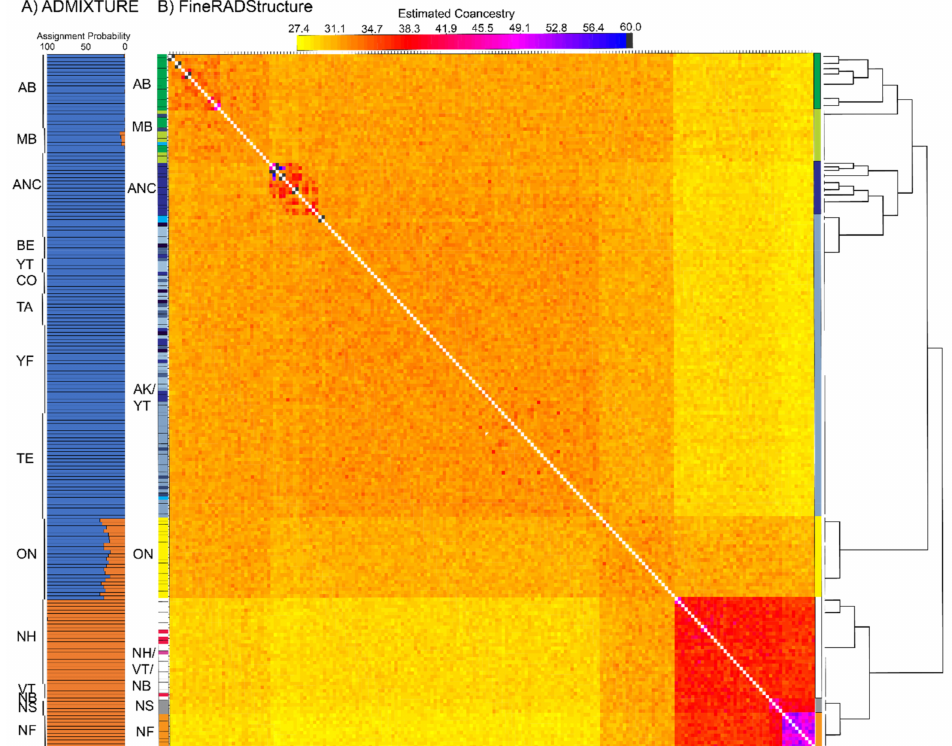
Figure 4. Population assignment analysis using the program ( A ) Admixture and ( B ) fineRADstructure. Average assignment probabilities for K = 2 inferred from bi-allelic single nucleotide polymorphisms in ADMIXTURE. FineRADStructure co- ancestry matrix indicating pairwise genetic similarity between individuals. Inferred populations are indicated by clustering in accompanying dendrogram and locations are indicated by color blocks for general region (solid blocks on right, color was chosen based on locale making up highest proportion of cluster) and by individual (single bars at left). Colors correspond to sampling locations indicated in Figure 1. Co-ancestry values were capped at 60 for illustrative purposes as only a few comparisons were above that value (see Supplementary Figure